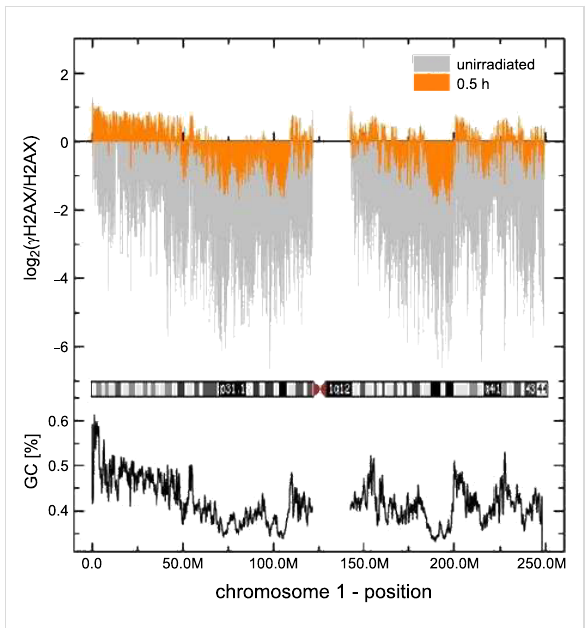
Figure 4: The phosphorylated H2AX distribution after radiation is correlated with the GC base content (a genomic feature associated with high gene content) of the transcriptionally competent and relaxed chromatin (euchromatin). The chromosome 1 profile is shown in the cartoon, with dark bands corresponding to heterochromatin and light bands to euchromatin (from chromosome G-banding). Preliminary ChIP-Seq data show that the γ H2AX signature (orange) is enriched in high-GC-content DNA sequences (black line, below) and dark chromo- somal bands (e.g., p31.1, q41), corresponding to a very low GC content are underrepresented. From [14] – Copyright: GSI Helmholtzzentrum für Schwerionenforschung